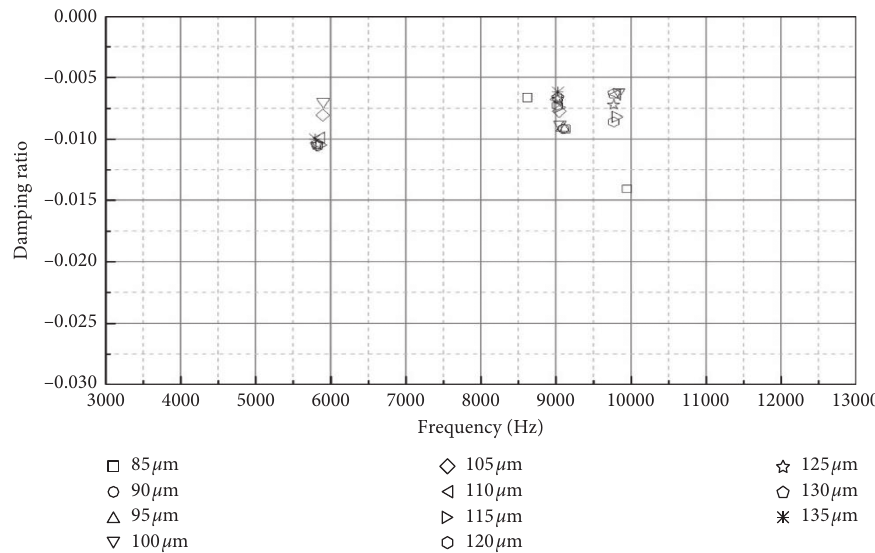
Figure 9: Noisy-mode distribution in Group